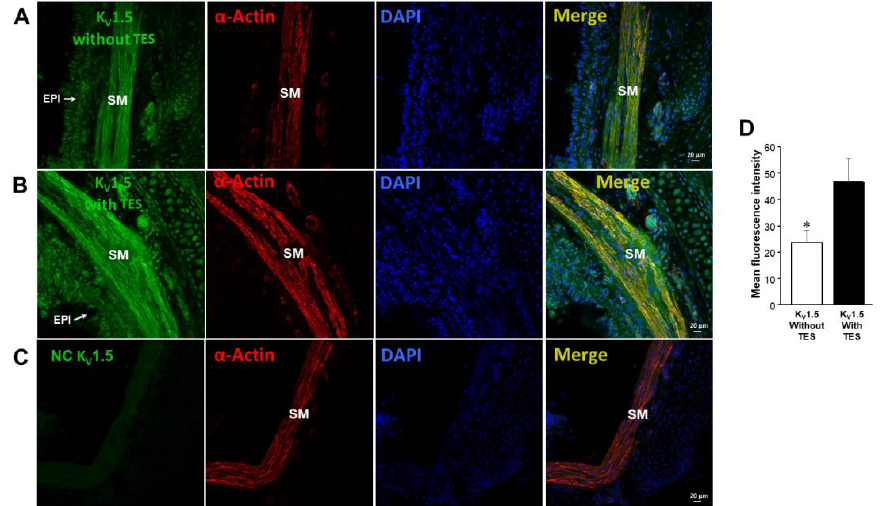
Figure 8. The testosterone (TES)-elicited genomic effect on the enhanced theophylline response is also related to the upregulation of K V 1.5 in guinea pig airway smooth muscle. The first column shows K V 1.5 immunofluorescence (green color) in guinea pig tracheal tissues without ( A ) and with ( B ) 40 nM TES exposure for 48 h. Note the increase in fluorescence when tissues were exposed to TES. ( C ) The absence of a primary antibody for K V 1.5 showed no fluorescence (NC = negative control). The second column shows smooth muscle α -actin (red), and the third column illustrates nuclei (blue). The merged images of the first three panels are shown in the fourth column. ( D ) The bar graph summarizes the quantification of K V 1.5 levels expressed as mean fluorescence, n = 5. S.E.M. is indicated by error bars. Significance was determined using an unpaired two-tailed t -test. * p < 0.05. SM = muscle, and EPI = epithelium.